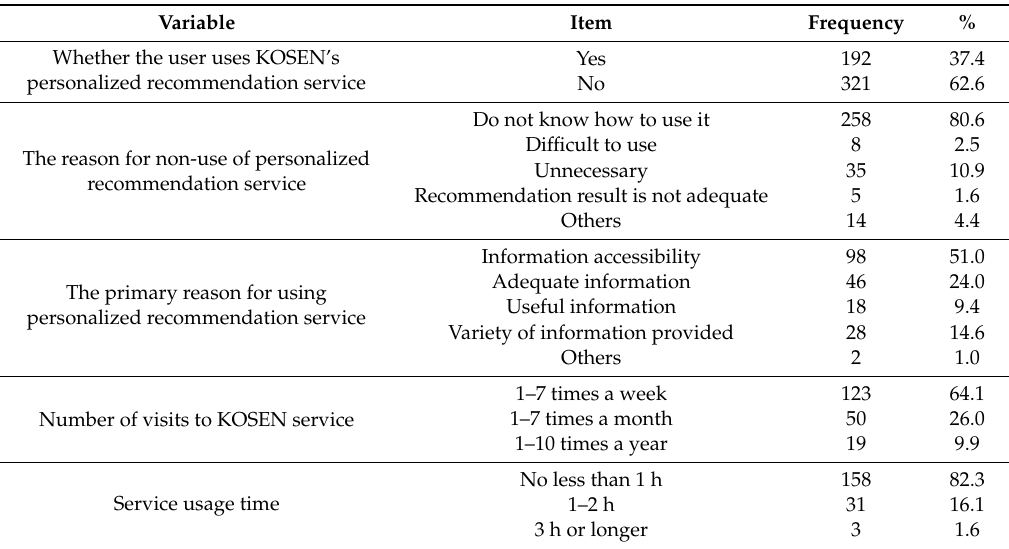
Table 5. Usage behavior of the